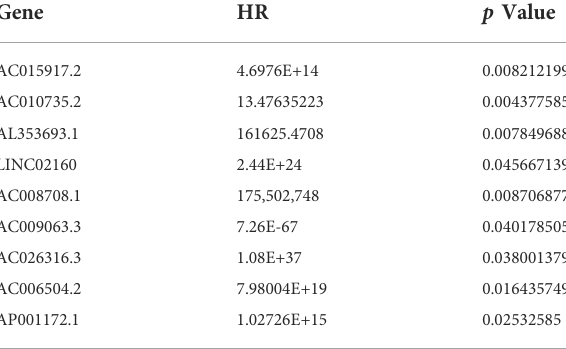
TABLE 2 The univariate Cox regression analysis demonstrating nine m6A-related